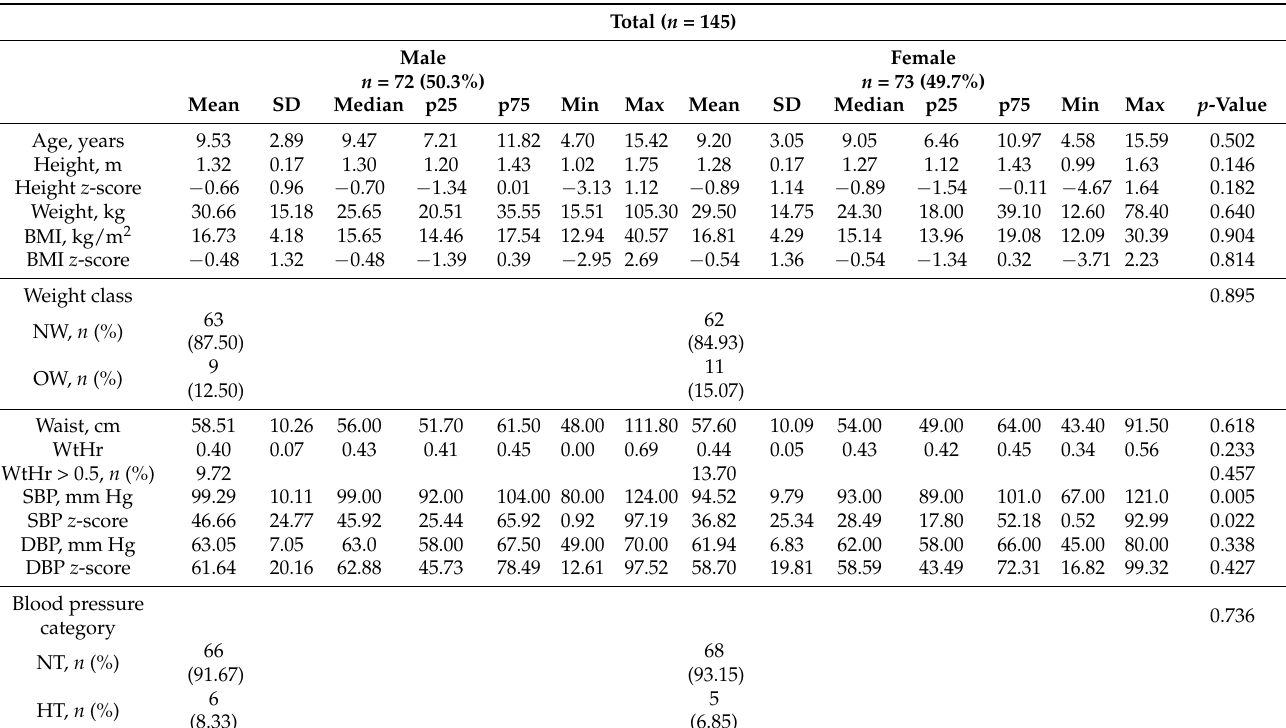
Table 1. Baseline characteristics of the 145 enrolled subjects subdivided according to